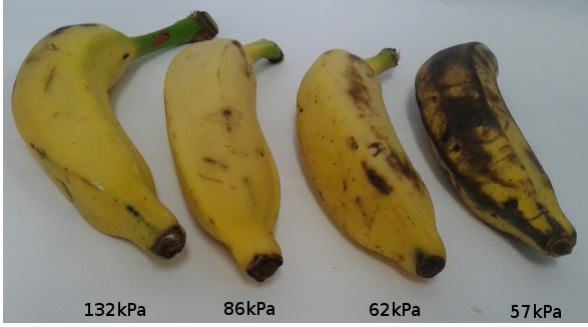
Figure 15. Turgor pressure in Kilo-Pascal (kPa) measured with the glove for banana. The fruit on the left is more unripe and the one on the right is more ripe.